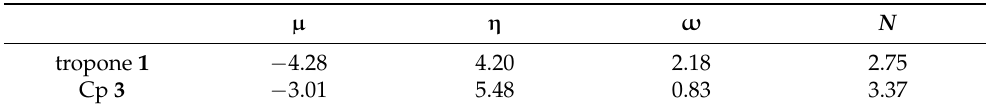
Table 1. B3LYP/6-31G(d) electronic chemical potential μ , chemical hardness η , electrophilicity ω , and nucleophilicity N , in eV, of tropone 1 and Cp 3 .